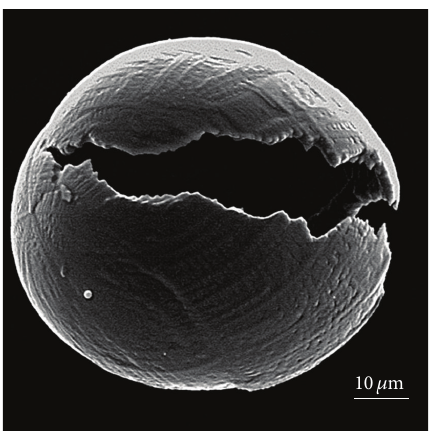
Table 1: Chemical composition and percentage of elements